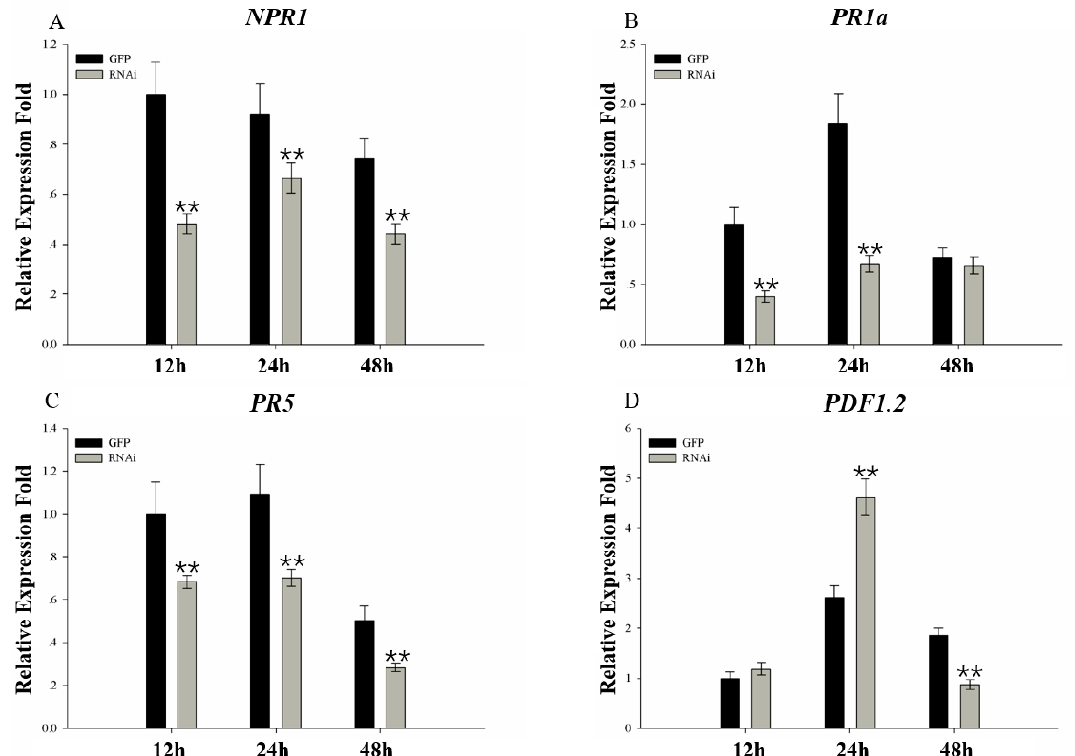
Figure 8. Expression profiles of NPR1 , PR1a , PR5 and PDF1.2 in the transgenic hairy roots. Expression of marker genes NPR1 , PR1a and PR5 in the SA signaling pathway and PDF1.2 in the JA pathway was detected in the RNAi hairy roots as well as the mock ones. The hairy roots were inoculated with zoospore suspension (about 10 4 zoospores/mL) of P. sojae P6497. Samples were collected at 12, 24 and 48 hpi. The expression levels are normalized to GmCons4 gene as an endogenous control. ** indicate significant difference from control at p < 0.01, respectively.